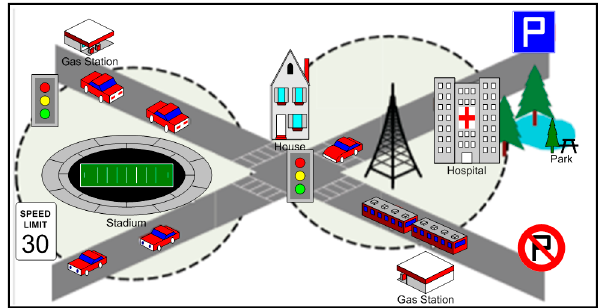
Figure 1. Pure cellular wireless local area network.